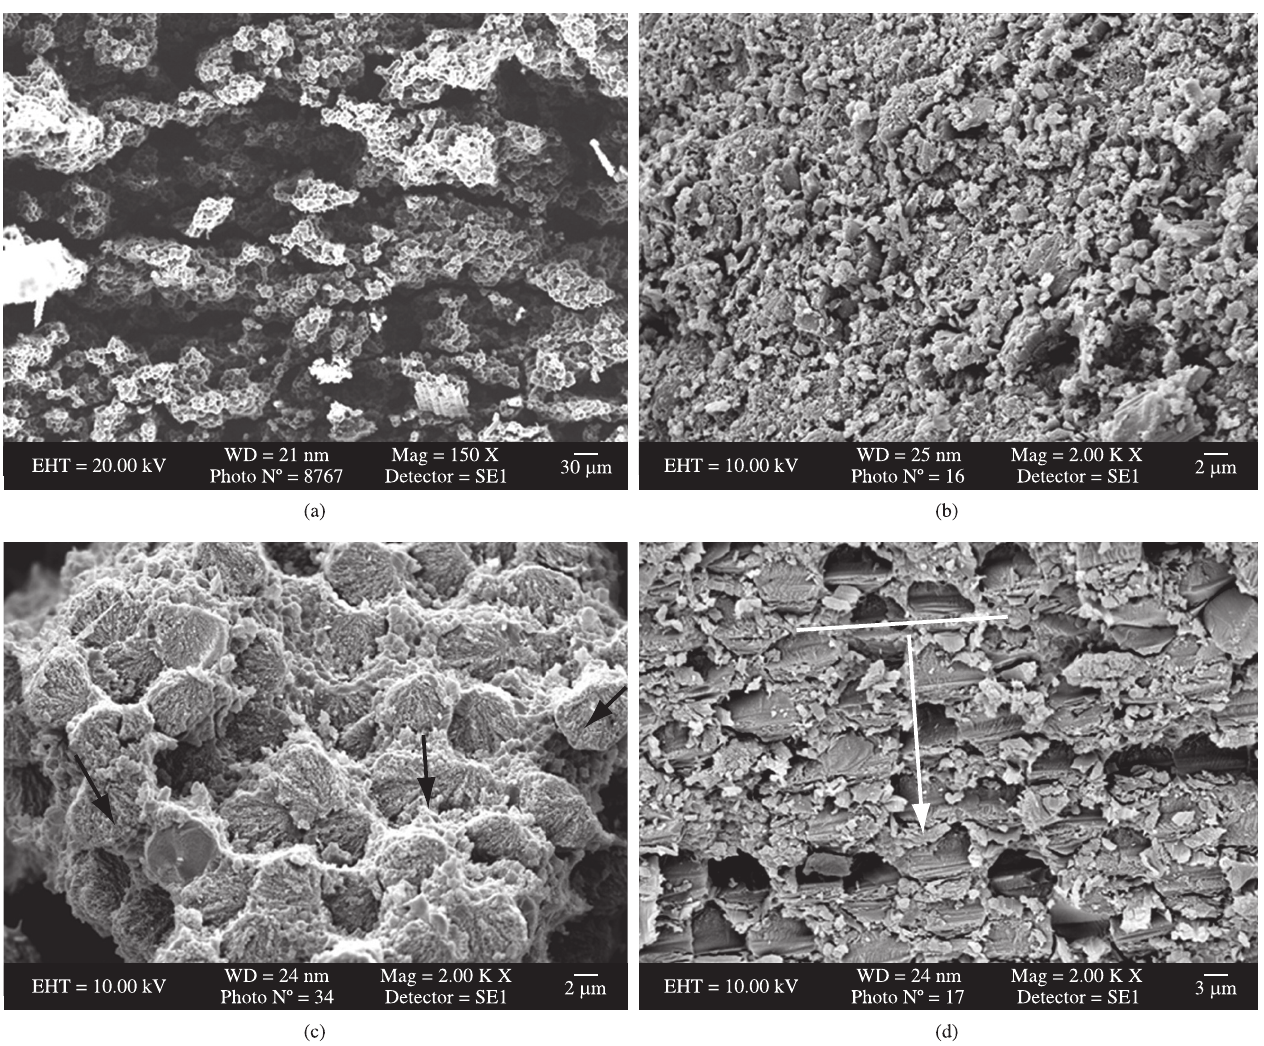
Figure 10. a) Fiber pullout on tensile side; b) Crushed and rub surface on compression side; c) Fiber radials on tension fractured fiber ends at higher magnifications; and d) Chop marks on compression side can be observed at higher